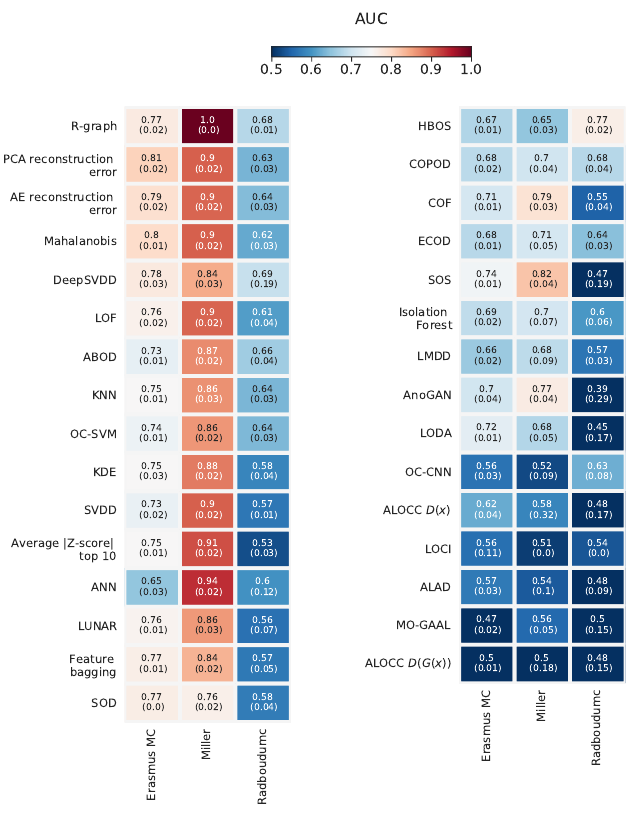
Figure A11. Overview of the average AUC plus standard deviation (between parentheses) on the AUC obtained from the k-fold